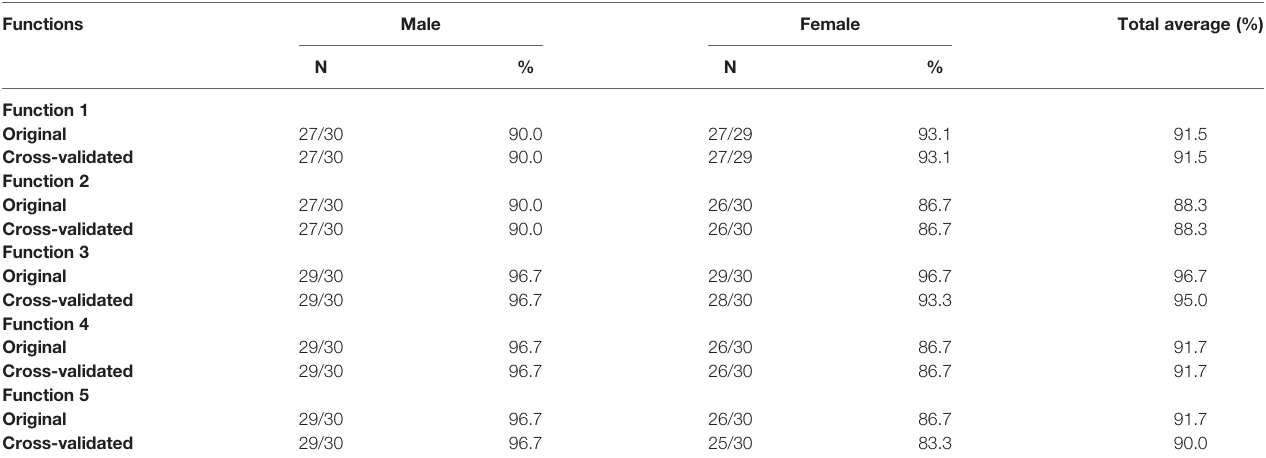
TABLE 9A | Accuracy of classi fi cation results of the original and cross-validated samples (left side) a .